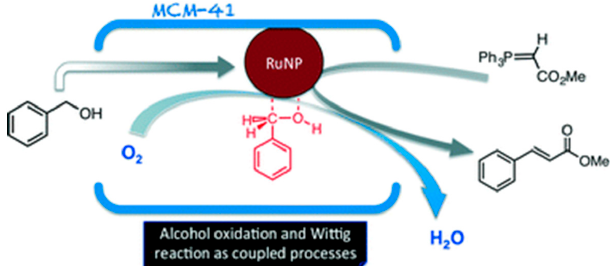
Figure 53. Proposed mechanism for the alcohol oxidation-Wittig olefination showing alcohol oxidation and olefination as coupled processes. Reproduced with permission from [121]. Copyright 2017 Royal Society of Chemistry.